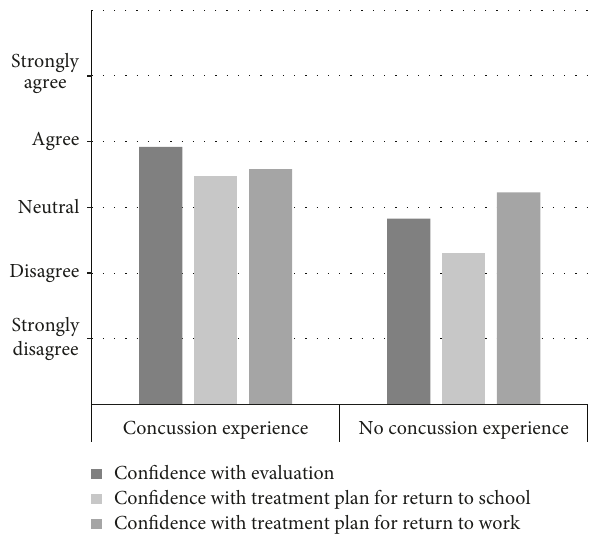
Figure 1: Perceived con fi dence and experience with